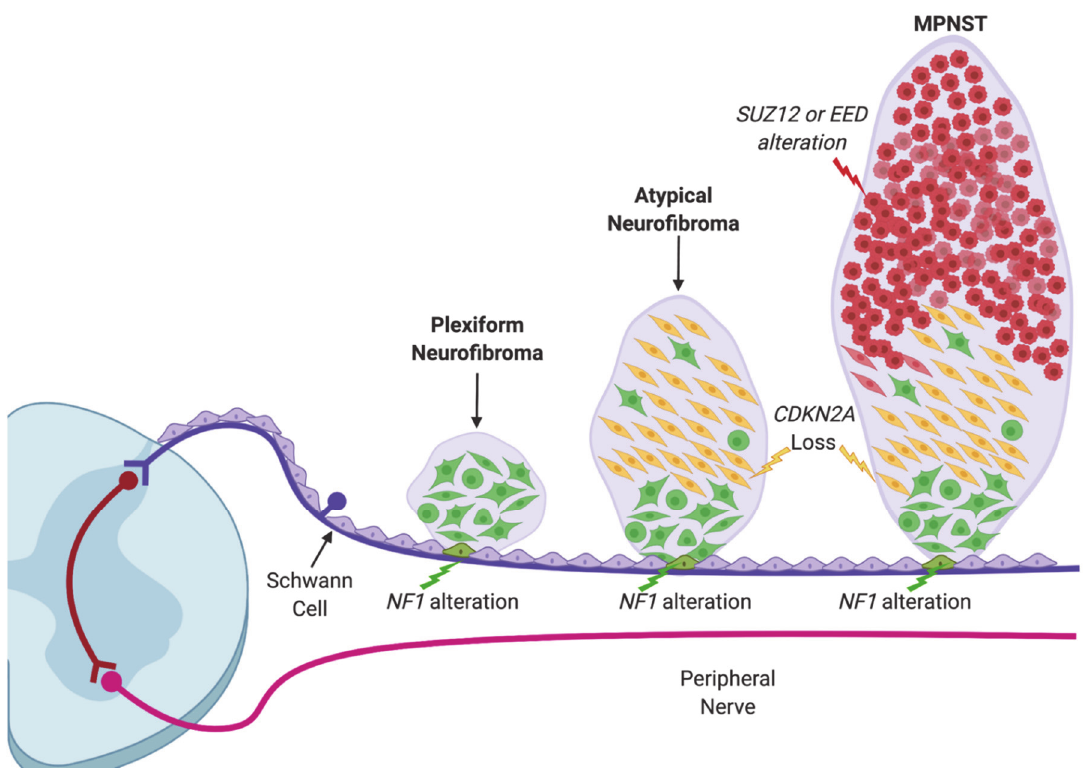
Figure 1. The clinical spectrum and genetic model of nerve tumor development in neurofibromatosis type 1 (NF1). Cells shown here are Schwann cells in the dorsal ganglia root and are affected by the sequential mutations driving the malignant transformation. Green: NF1 alteration, yellow: CDKN2A alteration, and red: PRC2 alteration.